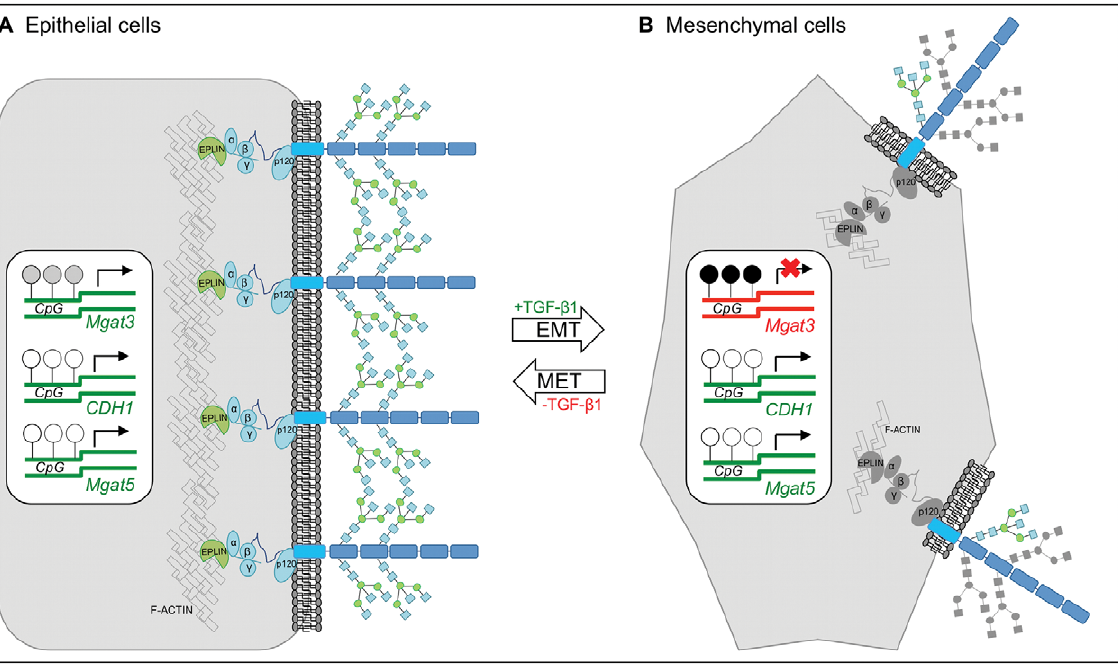
Figure 6. Proposed model. Panel A illustrates the following: in epithelial cells, CDH1 , Mgat3 and Mgat5 are transcribed. Partial promoter methylation of Mgat3 and no methylation of CDH1 and Mgat5 promoters were observed. The transcription levels of Mgat3 generate sufficient GnT-III enzyme levels that catalyze the addition of bisecting GlcNAc structures, specifically on E-cadherin. No information is available concerning the status of the remaining molecules in the adhesion complex (catenins). Panel B illustrates the following: in mesenchymal cells, Mgat3 ’s promoter is methylated in some CpG sites which were associated with a significant decrease of Mgat3 transcription. No significant changes were observed in terms of both promoter methylation status and transcription of CDH1 and Mgat5 . There was a significant decrease of GnT-III-mediated E-cadherin glycosylation. In reverted epithelial cells, Mgat3 ’s promoter methylation status returns to its status in original epithelial cells accompanied with a significant increase of Mgat3 transcription, in comparison to mesenchymal cells. Concomitantly there was an increased GnT-III-mediated E-cadherin glycosylation, resembling that observed in original epithelial cells.